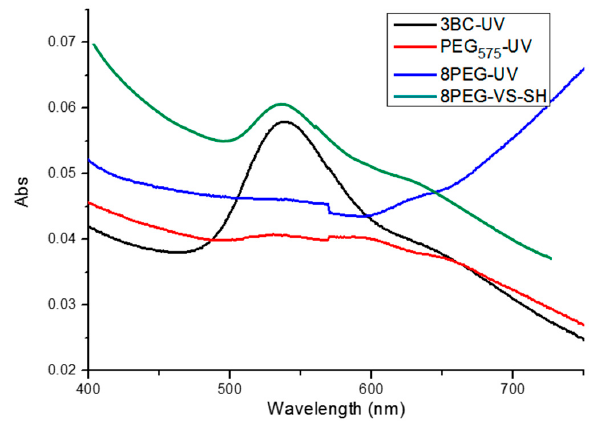
Figure 2 . UV-vis spectra of the as-synthesized gold nanocomposite hydrogels.